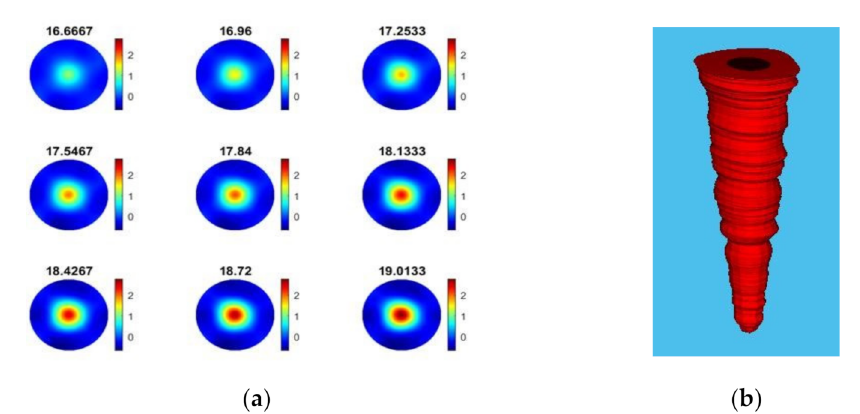
Figure 12. Calcium carbonate crystallization monitoring: evolution of the particle concentration and formation of a central vortex toward the end of the process (time: 16.6 min to 19 min). Experiments are related to trial 1 in Figure 10; operating parameters are listed in Table 3. ( a ) The TOF images frames, ( b ) growth of dispersed phase.